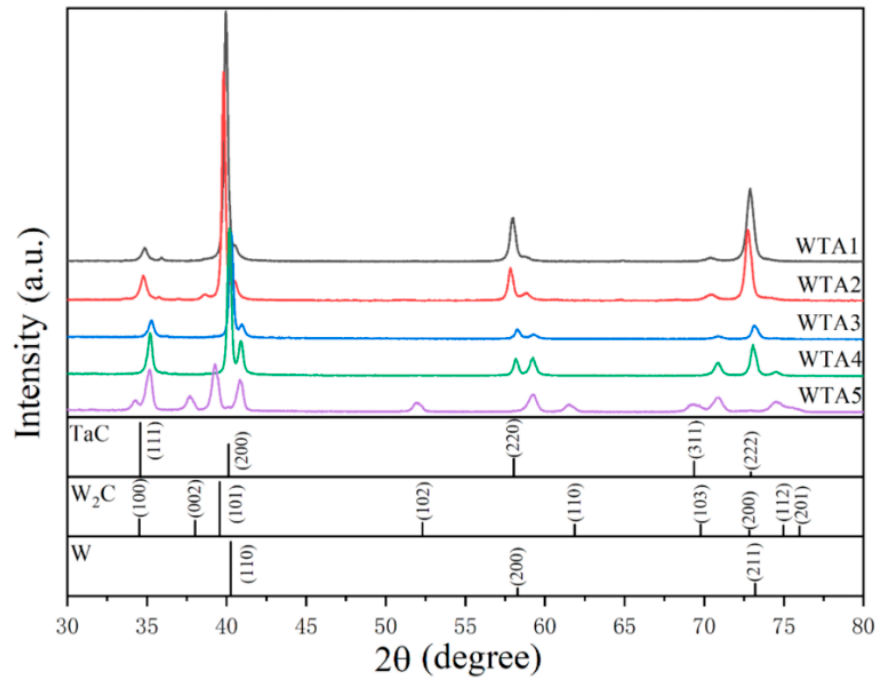
Figure 1. Phase compositions of the as-sintered W-TaC composites.